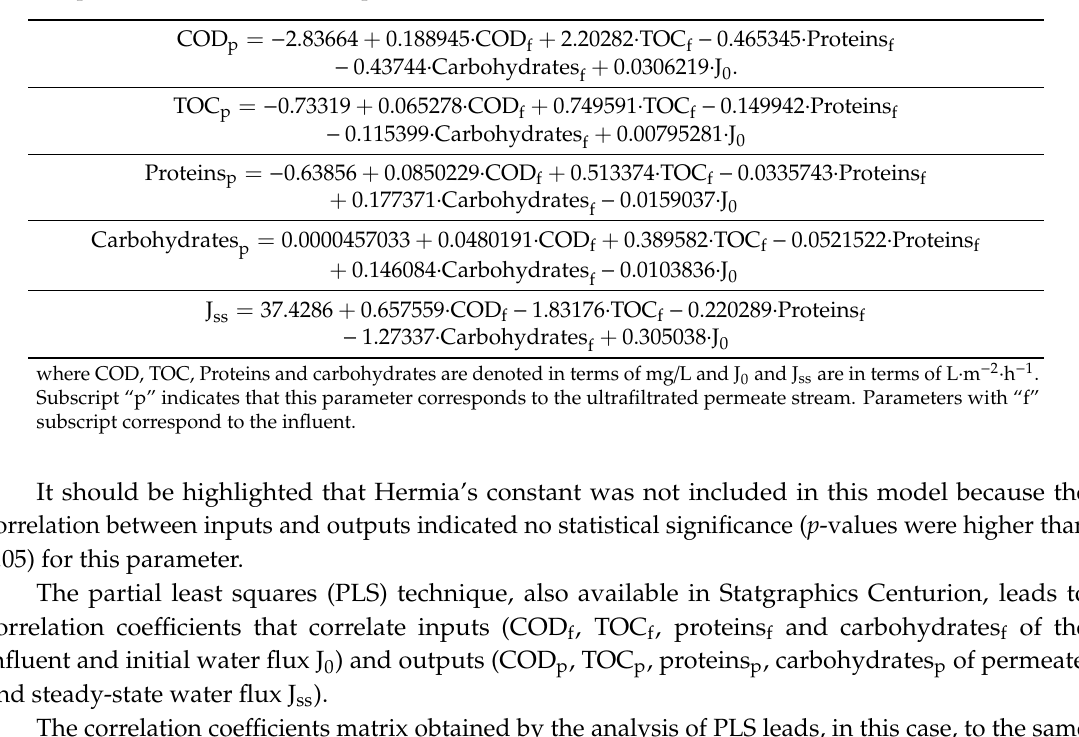
Table 4. Equations from the multiple regression statistical model (correlation coe ffi cients) for the sample after ultrafiltration tests (permeate).